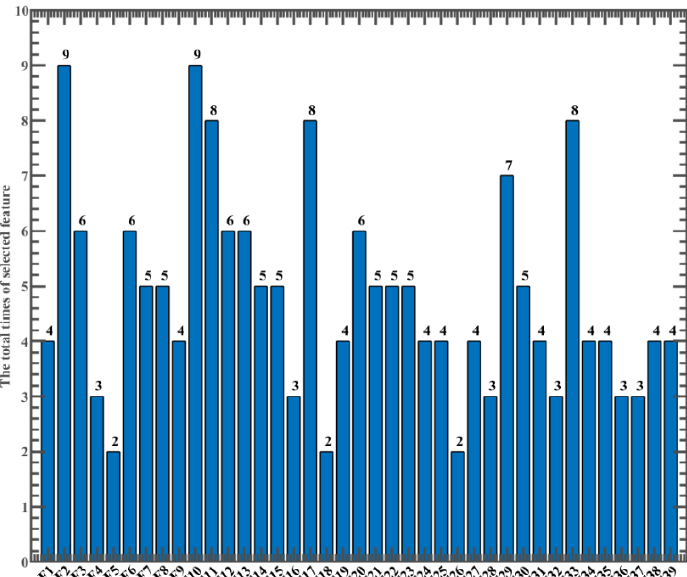
Figure 9. Frequency of the features chosen from CBBOA-SVM through the 10-fold CV procedure.